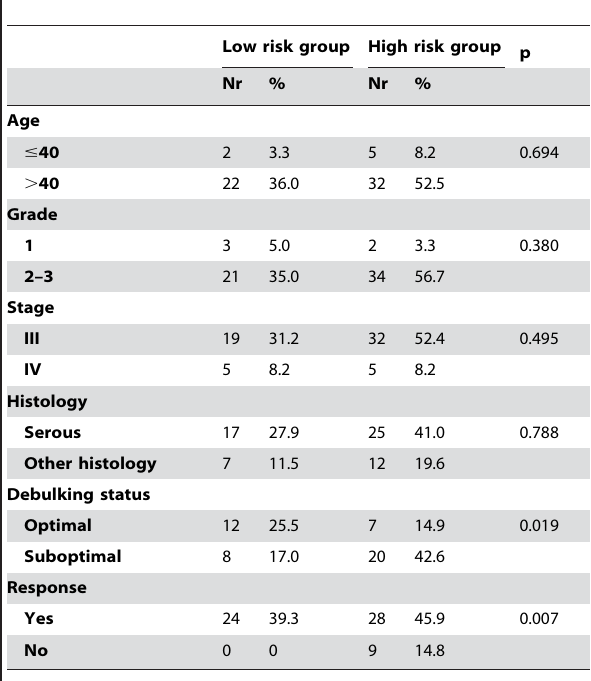
Table 2. Relationship between the angiogenesis-related gene profile and clinico-pathological